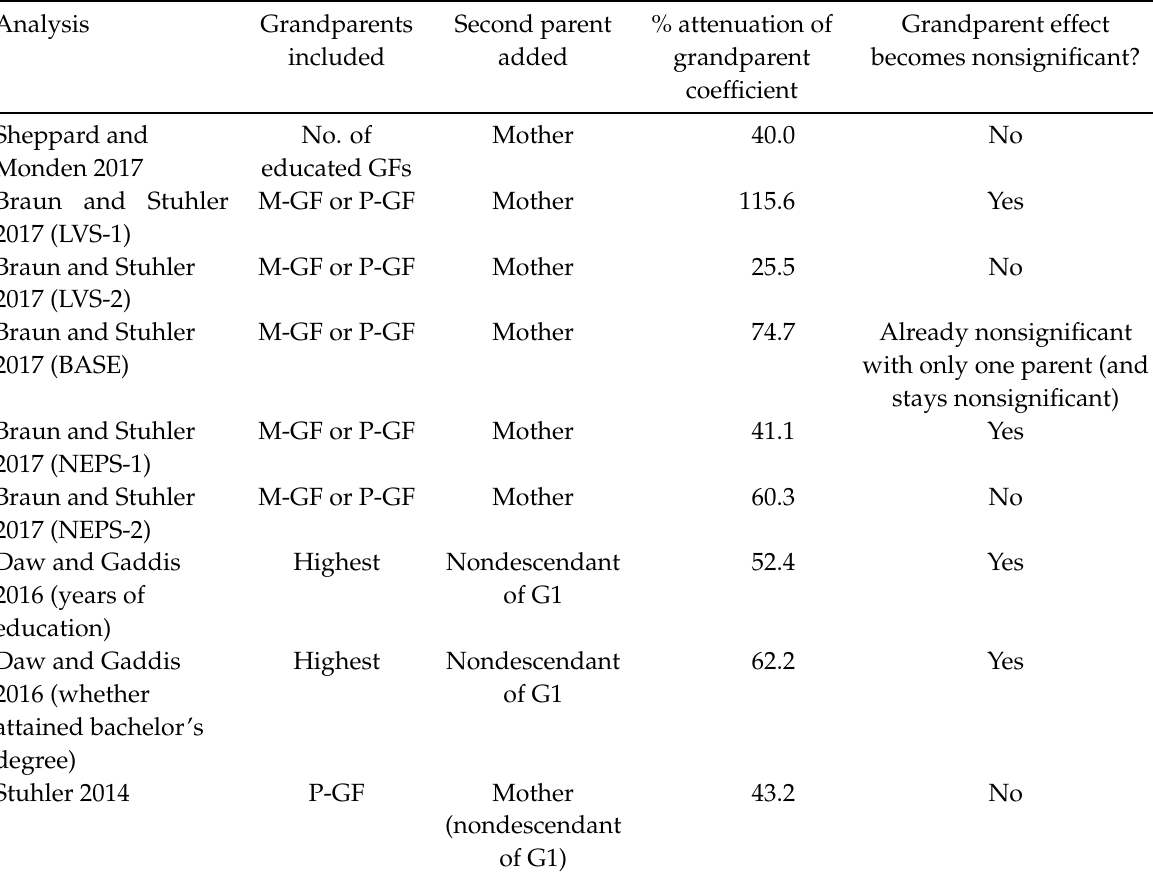
Table 2: Analyses presenting separate results including one parent and then both.